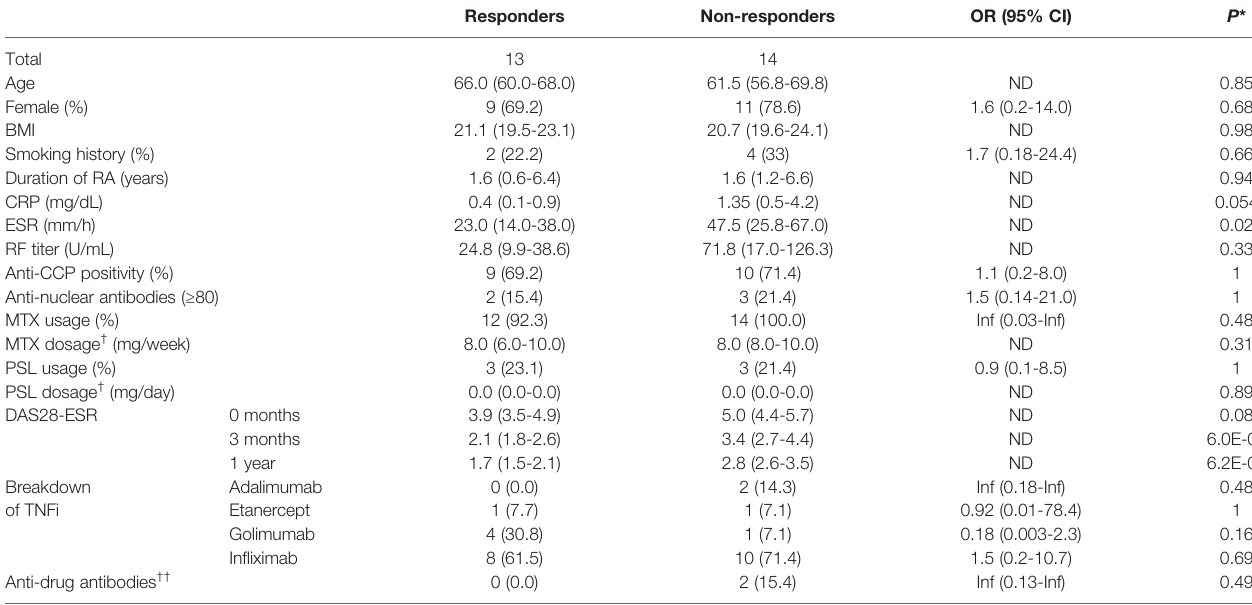
TABLE 1 | Clinical characteristics of study